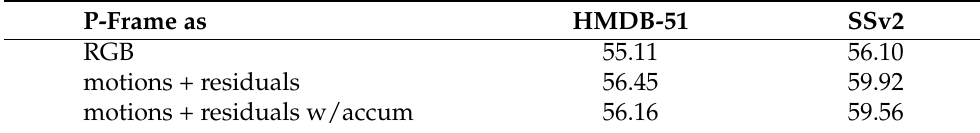
Table 3. Top 1 accuracies on HMDB-51 and SSv2 using each type of P-frame for input into model. Here, we do not use IPS. The abbreviation ”accum” indicates P-frame